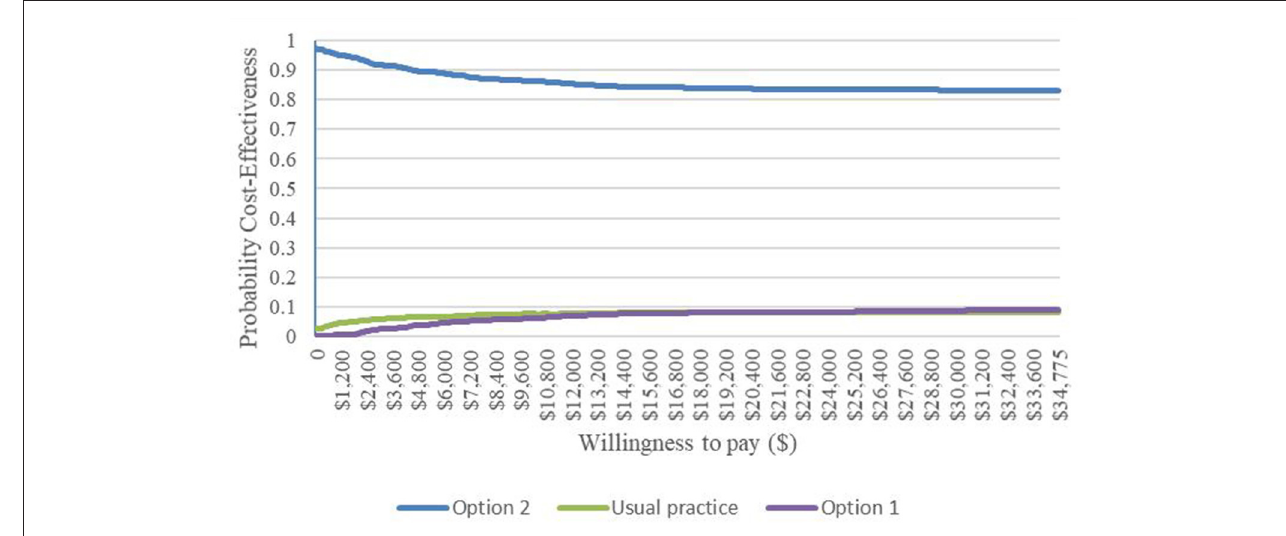
FIGURE 3 | Cost-effectiveness acceptance